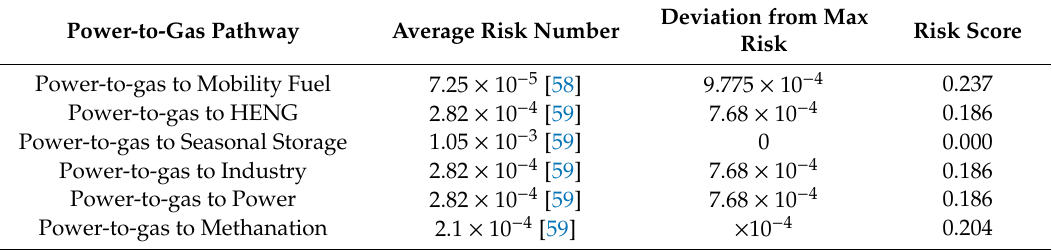
Table 13. Risk Number for power-to-gas